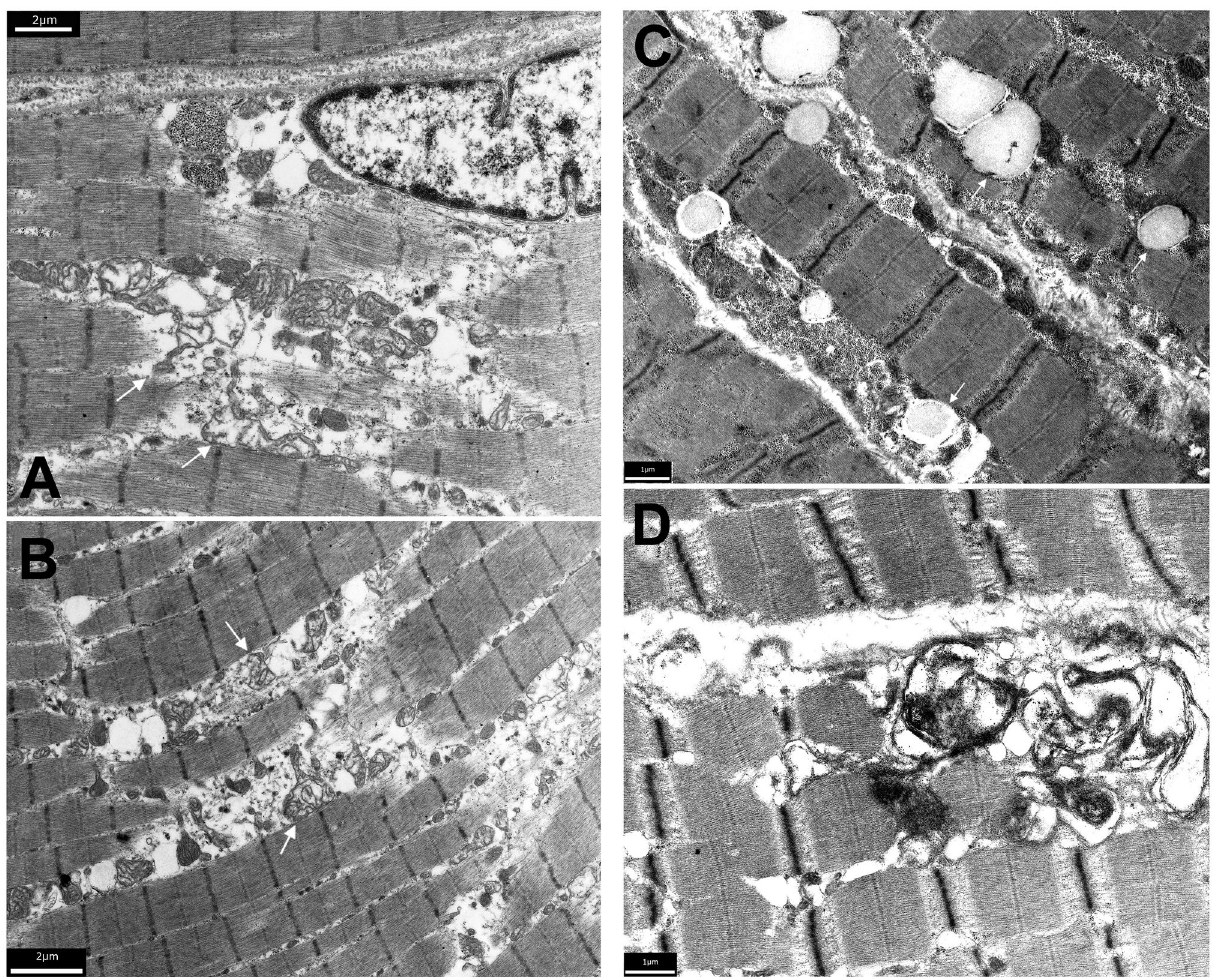
Figure 5. Electron microscopic alterations in the muscle biopsy of patient F6 (P1), age 12 years. (A and B) There is enlargement of the sarcoplasmic space between myofibrils associated with focal increase in granular and membranous material (arrows). The membranes are probably derived from the sarcoplasmic reticulum/myotubular system and from disintegrated mitochondria. There were no myonuclear inclusions. (C and D) Electron microscopic analysis of the muscle biopsy of patient F1 (P1), age 3 years. (C) Lipid droplets (arrows) in muscle fibres are moderately increased in size and number. (D) Subsarcolemmal accumulation of membranous material indicating proliferation of sarcoplasmic reticulum membranes.